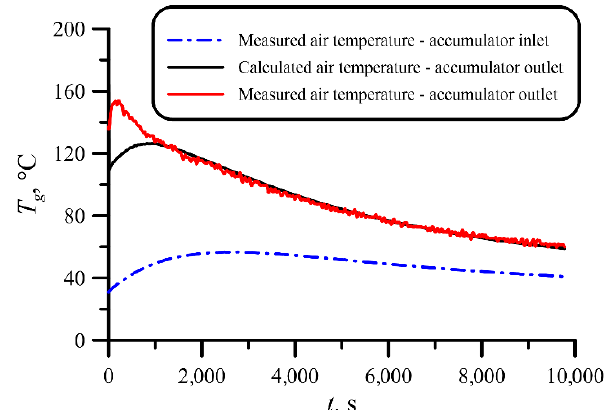
Figure 13. Measured air temperature at the accumulator inlet and comparison of the measured and calculated air temperature at the accumulator outlet as a function of time.